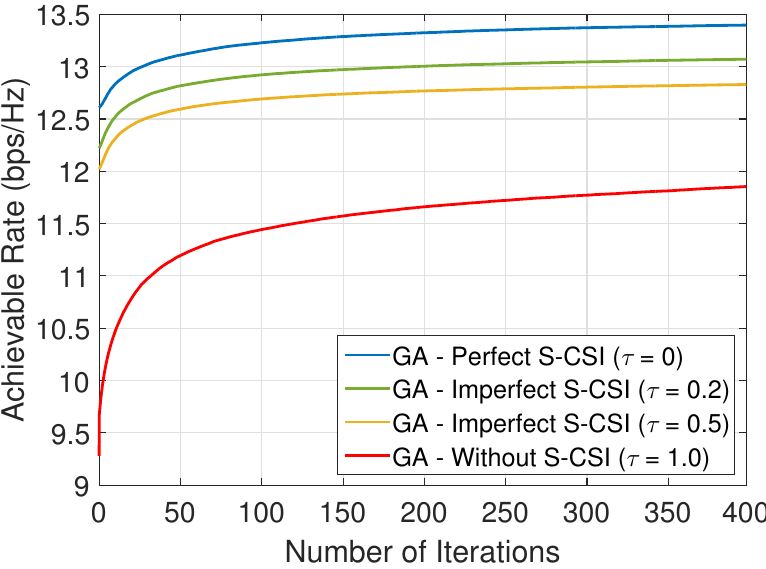
Figure 9. Convergence of the proposed solution with perfect and imperfect S-CSI for M = 20 and ( x u , y u ) = (95,8) m, i.e., d ∼ 5 IU